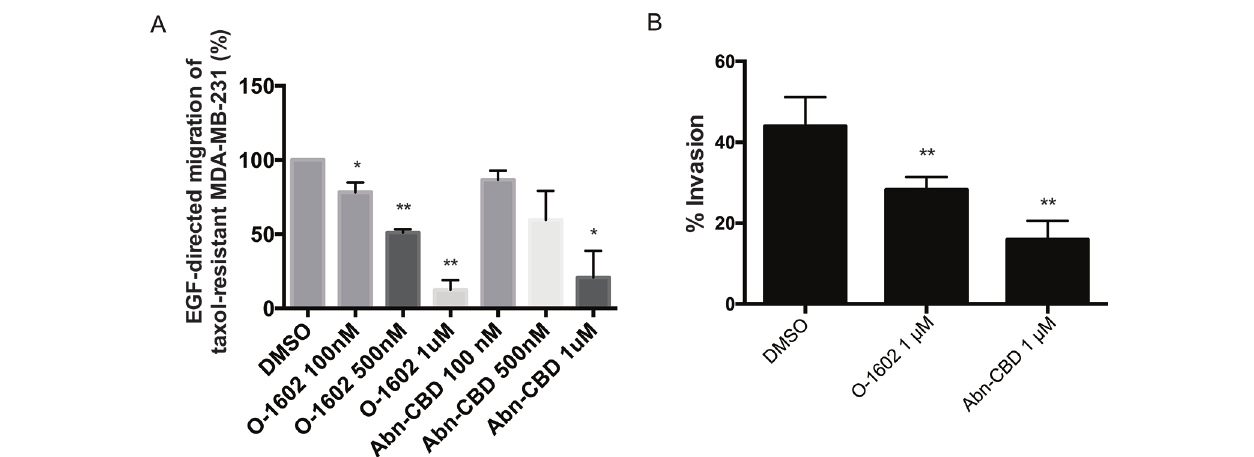
FIGURE 6 | Effect of atypical cannabinoids on EGF-mediated migration and invasion. (A) Histogram summarizing Transwell migration results using MDA-MB-231 PR cells in response to EGF in presence of either the vehicle control or various concentrations of O-1602 or Abn-CBD. (B) Histogram summarizing Matrigel invasion